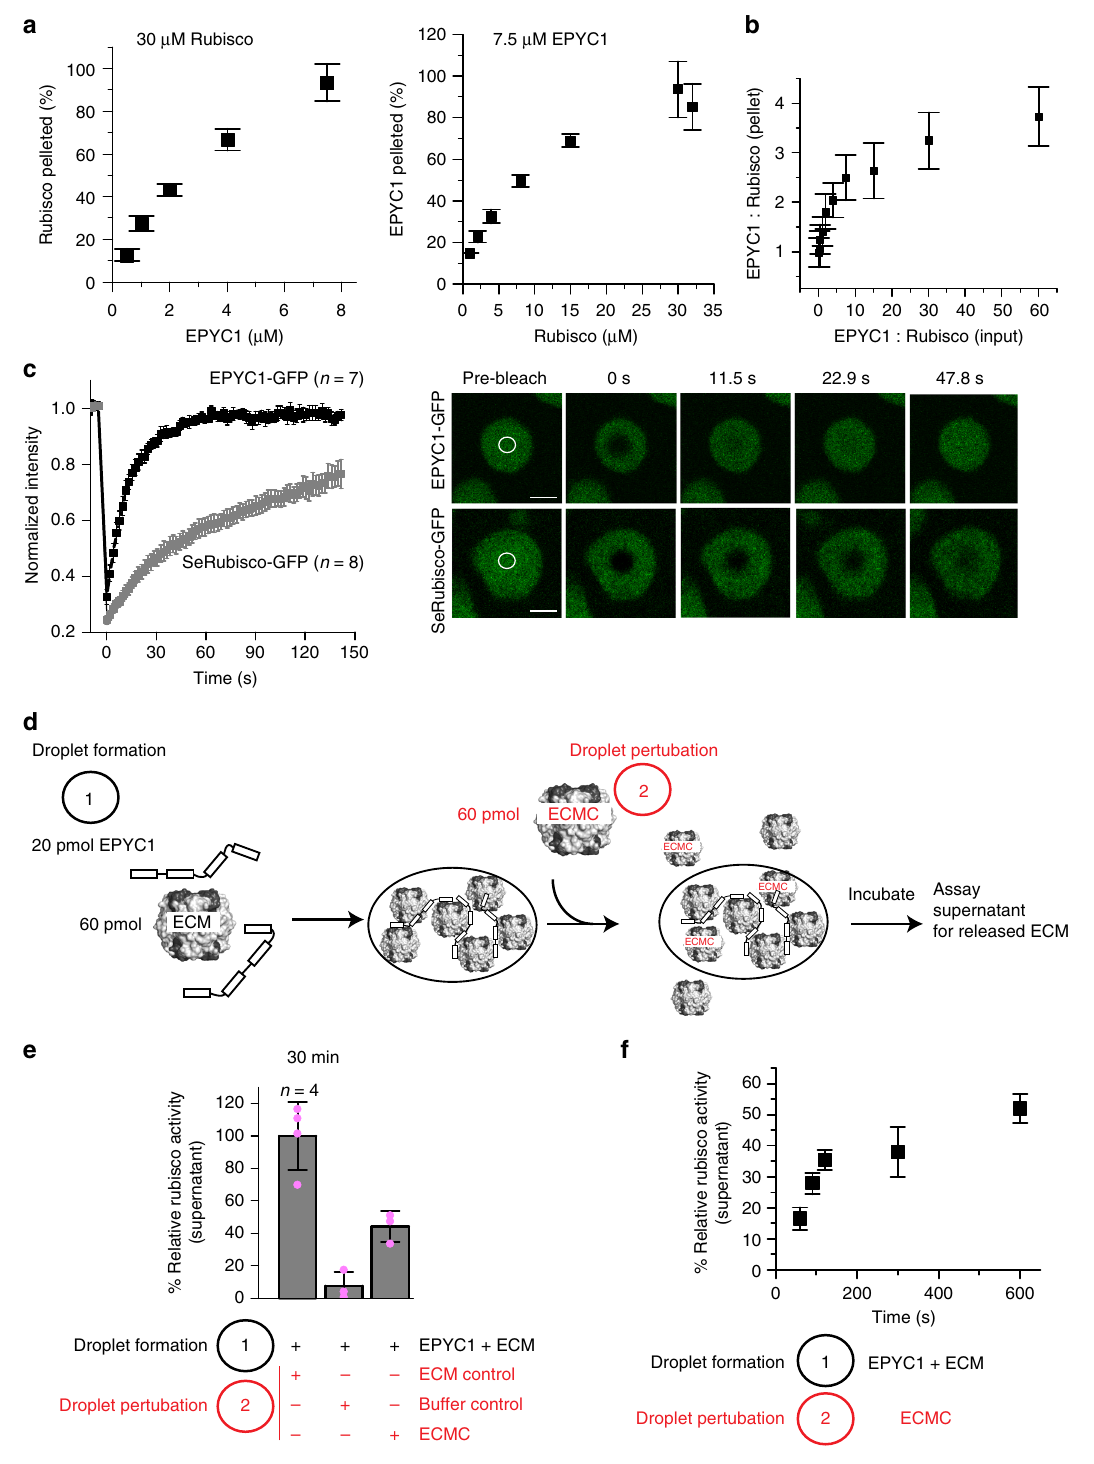
Fig. 3 Droplet composition is dynamic. a EPYC1 (left) and Rubisco (right) were titrated followed by SDS-PAGE and densitometric analysis of droplet composition. 30 µ M Rubisco:7.5 µ M EPYC1 (1 L 8 S 8 :2 linker proteins) resulted in complete demixing. b EPYC1:Rubisco stoichiometries in droplets range from 1 to 4. c Fluorescence recovery after photobleaching of demixed droplets (15 µ M Rubisco and 10 µ M EPYC1) labeled with either 0.1 µ M EPYC1-GFP or 0.2 µ M cyanobacterial Rubisco-GFP (SeRubisco-GFP). Error bars indicate the s.e.m. Scale bar 2 µ m. d Biochemical Rubisco exchange assay scheme. ECM active Rubisco, ECMC dead-end inhibited Rubisco. Droplets are formed using ECM (indicated as droplet formation 1), and an equal amount of ECMC is added after 3 min (indicated as droplet perturbation 2). Displaced Rubisco is measured by Rubisco assay of the supernatant. e Addition of non-functional ECMC to droplets formed with functional ECM results in displacement of ECM from the droplets. f ECM displacement kinetics. Error bars excluding c indicate mean and s.d. ( n = 3 unless indicated